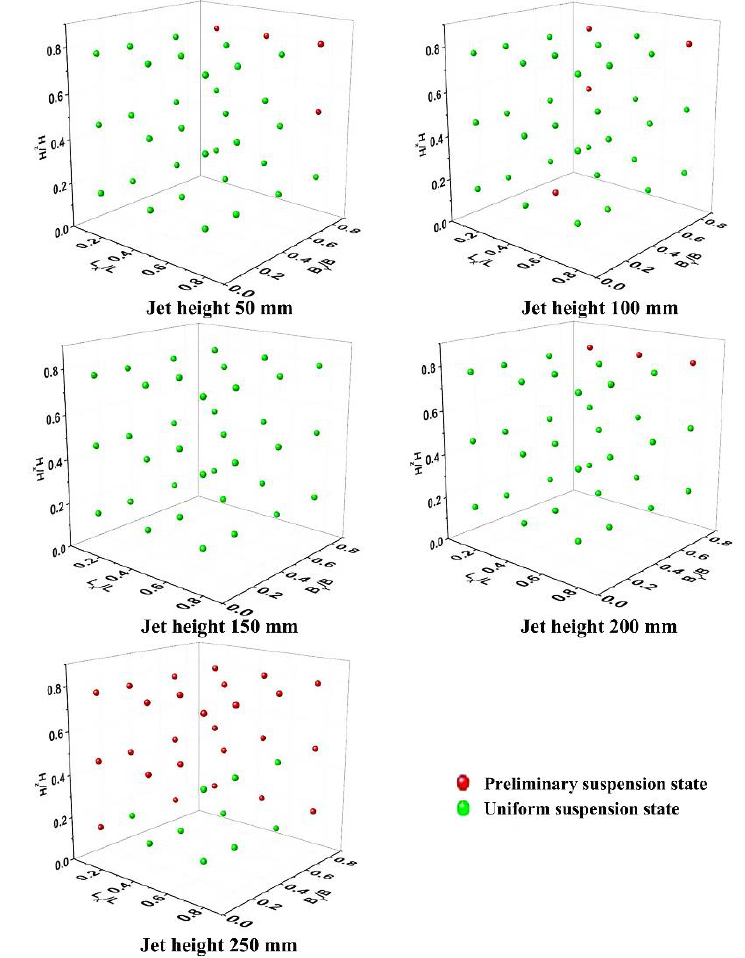
Figure 9. Suspension state of each sampling point under different jet